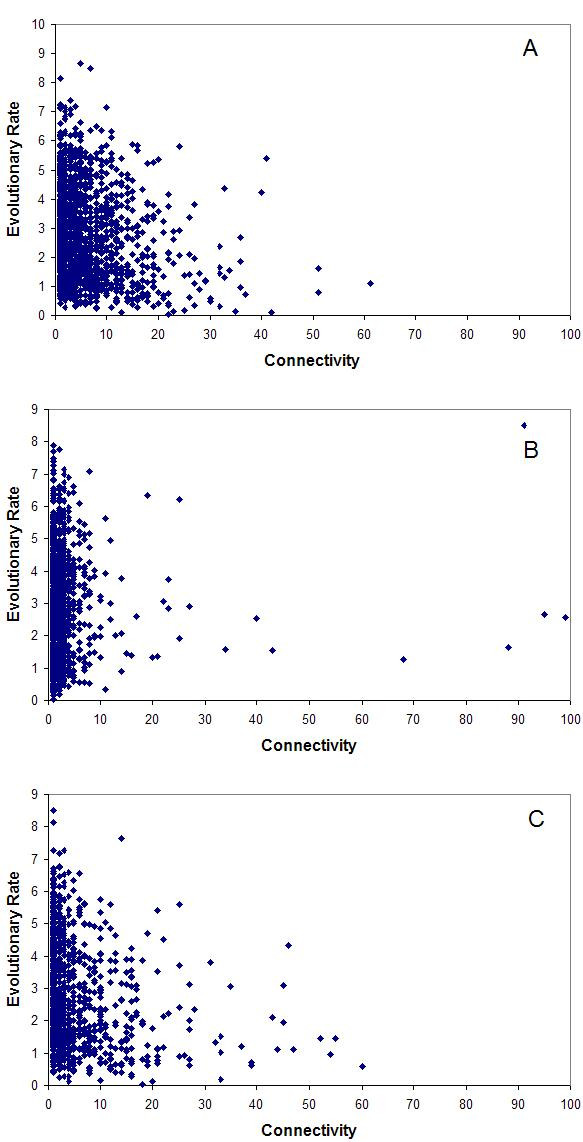
Observed Correlations. The observed correlations between interactions and evolutionary rate in three datasets. Correlations were statistically quantified using Spearman's rank correlation coefficient. A The correlation observed in the DIP_Core dataset ρ: -0.16819. Grishin's method was used to obtain evolutionary rate. B No correlation was observed in the INTACT_ITO dataset ρ: 0.03 C The INTACT_HO dataset showed our strongest correlation ρ: -0.227. Proteins with more than 100 interactions are not shown on the figures to aid clarity.